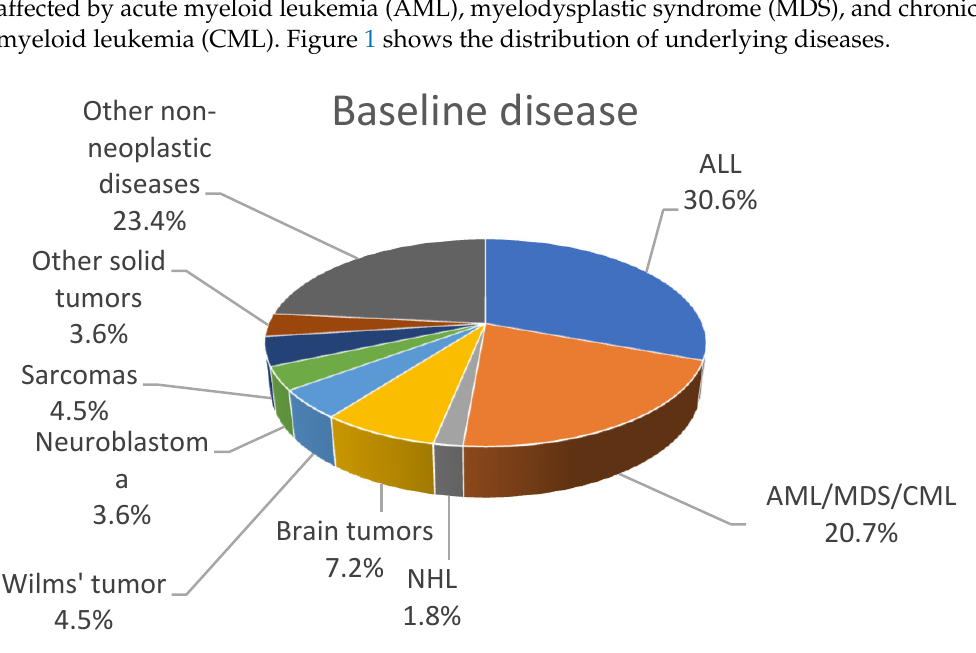
Figure 1. Distribution of underlying patient diseases.